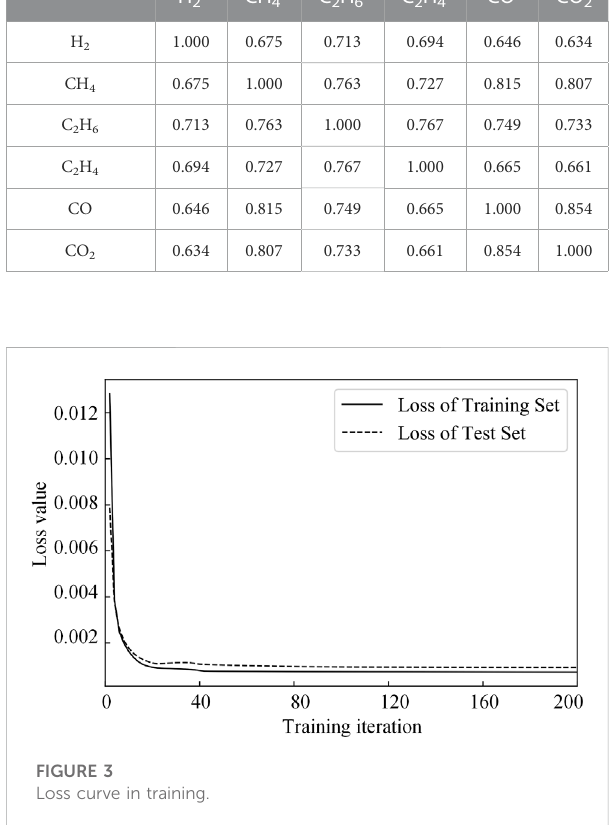
FIGURE 3 Loss curve in training.